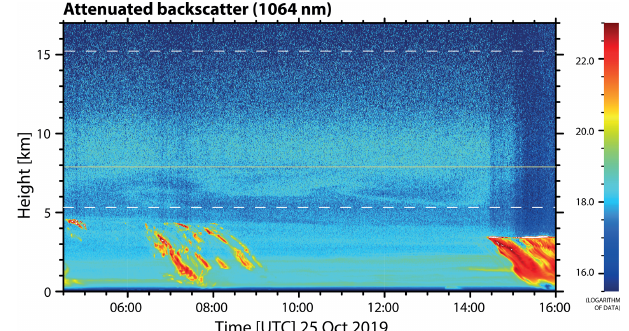
Figure 9. Wildfire smoke over RV Polarstern (85.4 ◦ N, 128.0 ◦ E) on 25 October 2019. The tropopause height, according to the Po- larstern radiosonde (launched at 11:00UTC), is given as an orange solid line, and the base and top height of the smoke layer are indi- cated by white dashed lines. Further haze layers and embedded cir- rus clouds (virga in yellow to red) are visible at heights below 5km. The uncalibrated attenuated backscatter coefficient at 1064nm (in arbitrary units) is shown.